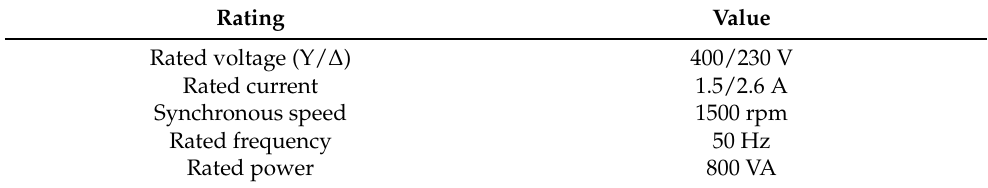
Table 1. Ratings of the laboratory synchronous machine according to the plate mounted on the